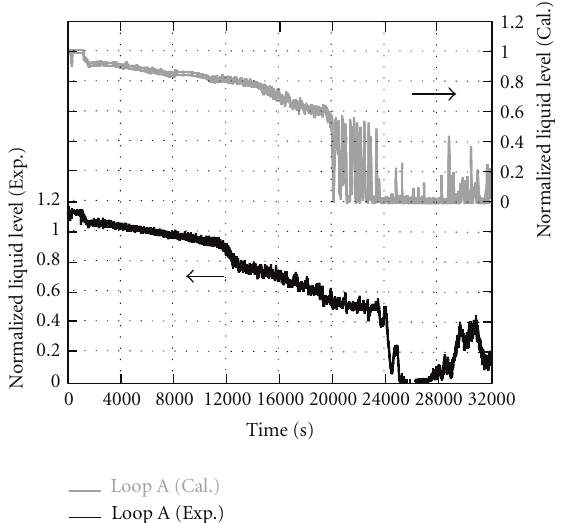
Figure 13: LSTF and RELAP5 results for SG inlet plenum collapsed liquid level in loop with PZR.